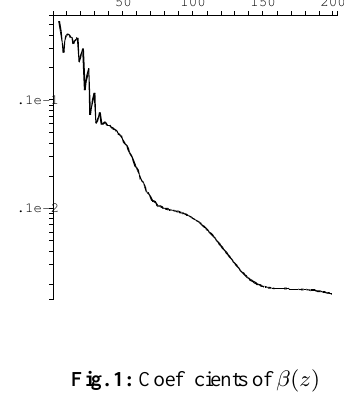
Fig. 1: Coefficients of β ( z